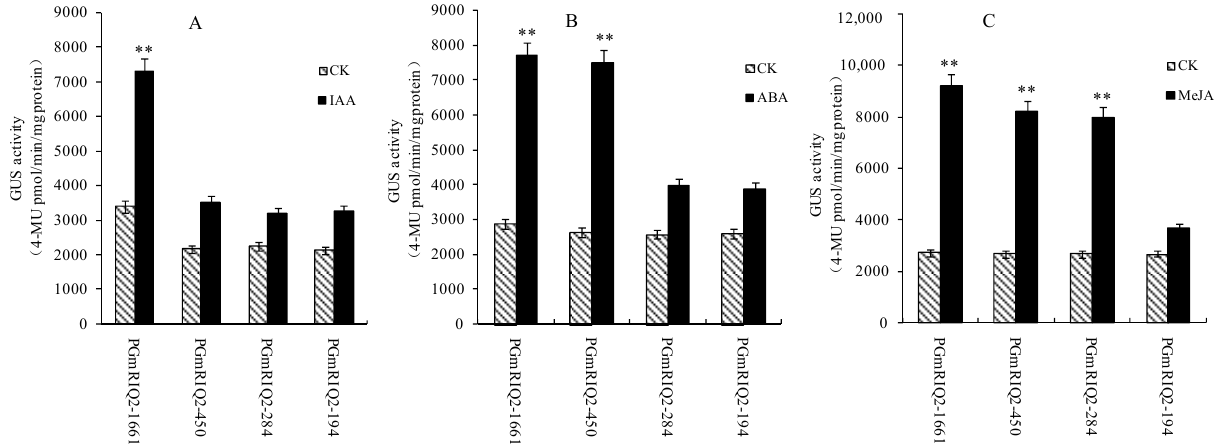
Figure 9. Hormone treatment after transformation of the GmRIQ2 gene deletion fragment promoter in Arabidopsis GUS . ( A ) IAA: 50 μ M; ( B ) ABA and ( C ) MeJA: 100 μ M. The data are shown as the mean ± SE of three independent replicates. ** indicate significant difference at 0.01 levels.